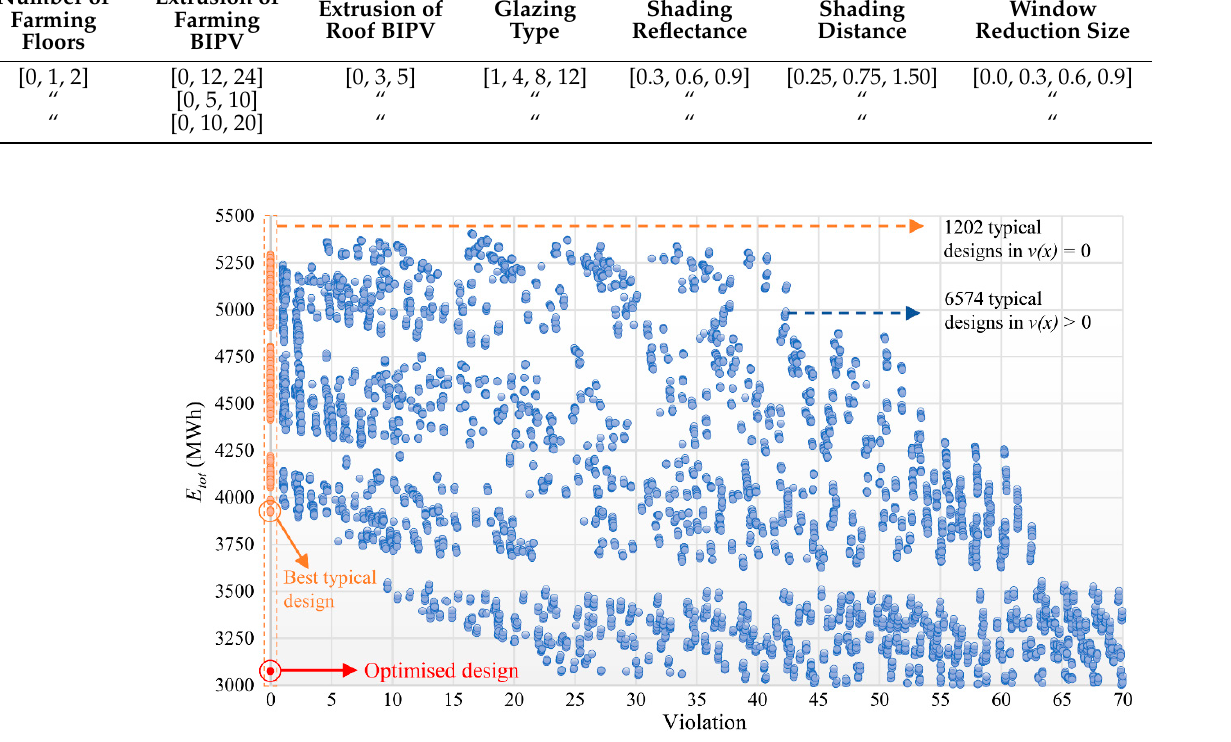
Figure 19. MUZO design versus 7776 typical scenarios.